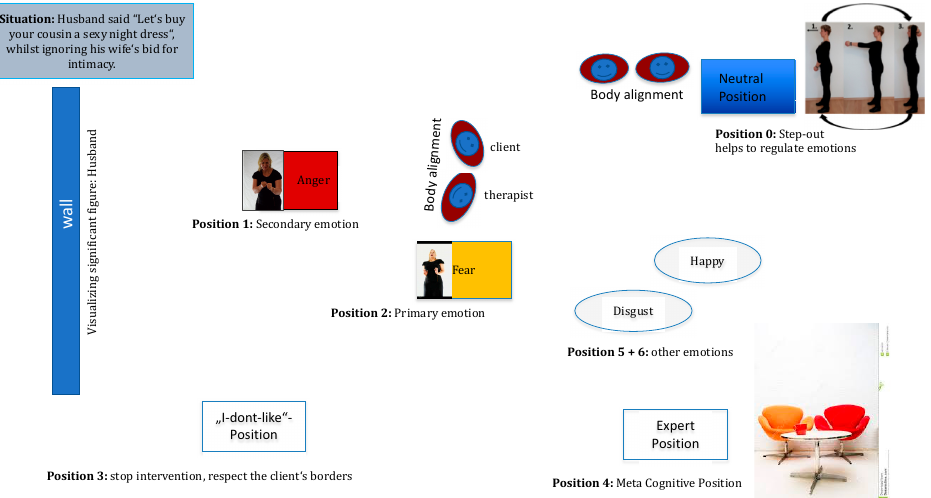
Figure 2. Hypothetical Emotional Field of a client.